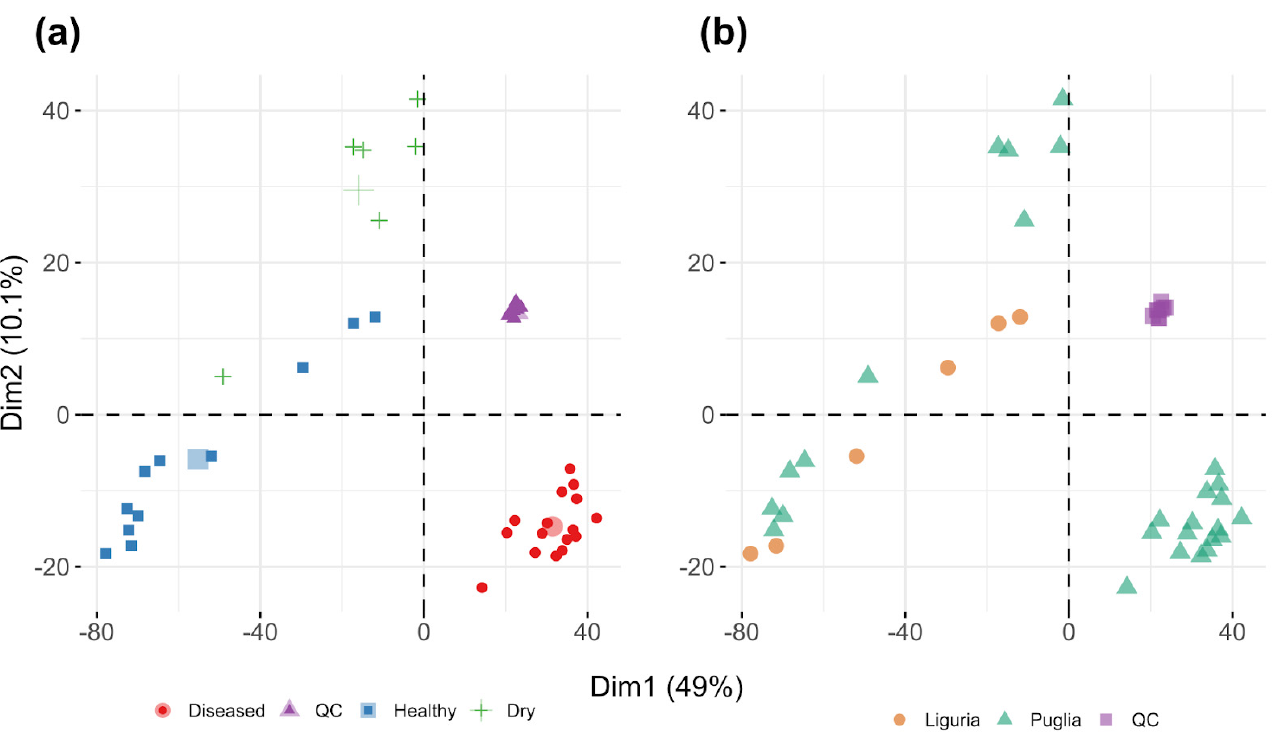
Figure 1. PCA score plots for all the samples analyzed: ( a ) bidimensional separation highlighting the infection state: red circles represent the diseased population, violet triangles the quality control (QC) samples, light blue squares the healthy samples and green crosses the healthy dried samples. For each sample class, the bigger symbol (circle, triangle, square and cross) represents its center of gravity. ( b ) bidimensional separation highlighting the origin factor; orange circles represent samples originating from Liguria, green triangles are used for samples originating from Puglia while violet squares for QC pooled samples.